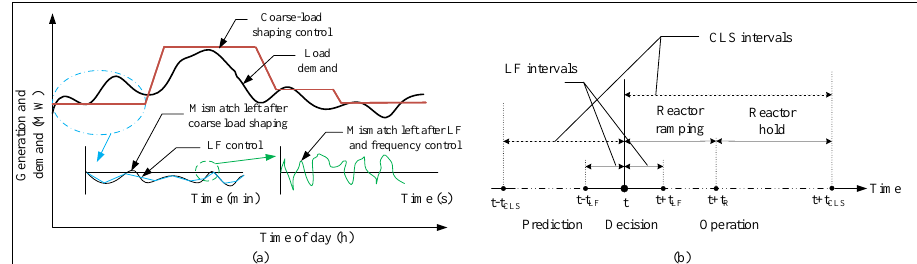
Figure 2. ( a ) Distributed control of the flexible operation assets to meet generation–demand balance; ( b ) real-time operational scheme for setpoint-based